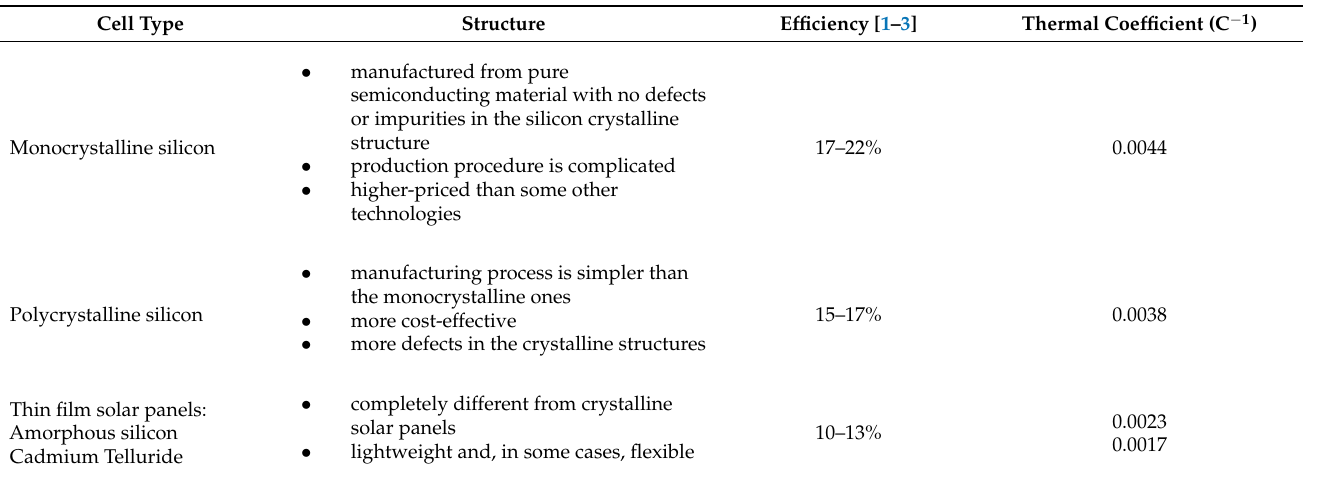
Figure 2. Expected value of output power of PV on each month for each technology. The main specifications of each technology are represented in Table 1. Table 1. The specifications of each